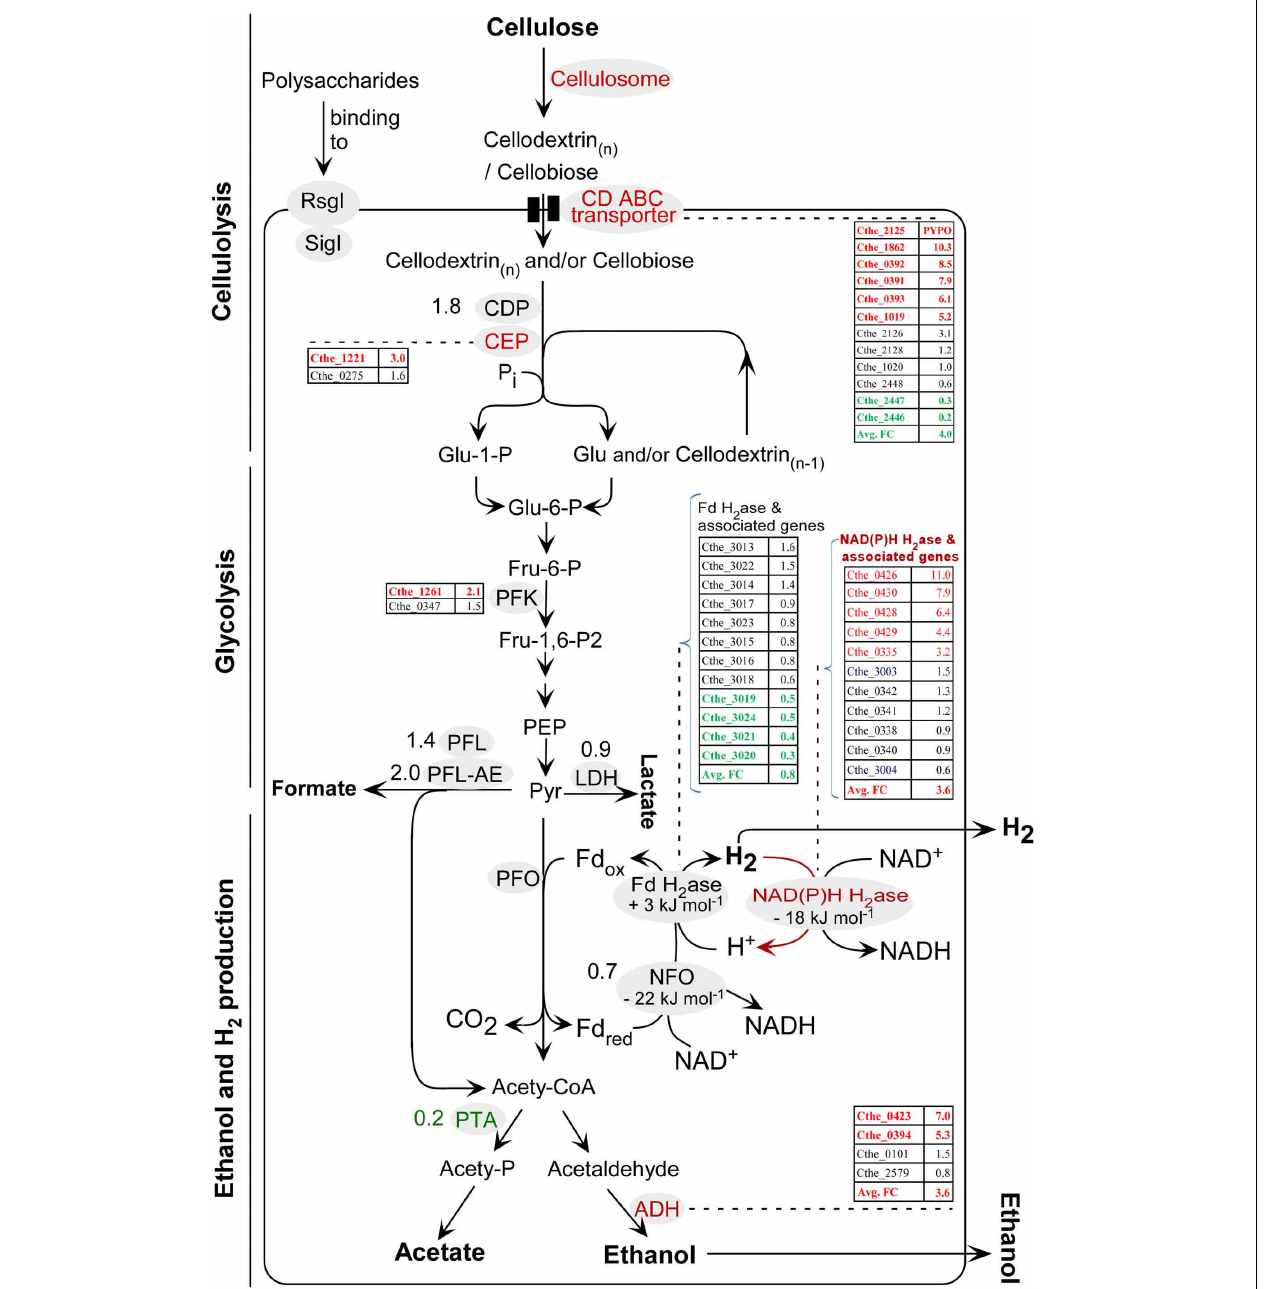
FIGURE 6 | Diagram for the primary steps in the conversion of cellulose to fermentation products using C. thermocellum ATCC 27405. SigI-RsgI (sigma factors coupled with membrane-associated RsgI-like anti-sigma factors) are also illustrated in this diagram as they have been proposed in literature for polysaccharide triggered signal transmission in regulation of GH family genes. Detailed nomenclature of enzymes and their associated gene IDs can be found in Supplementary Data Sheet 3, section 3 and Table 4 . For enzymes associated with a single gene ID, the gene ID is not included in the figure; instead, its fold change (FC) value is indicated directly beside the enzyme. For enzymes associated with multiple gene IDs, the gene IDs and